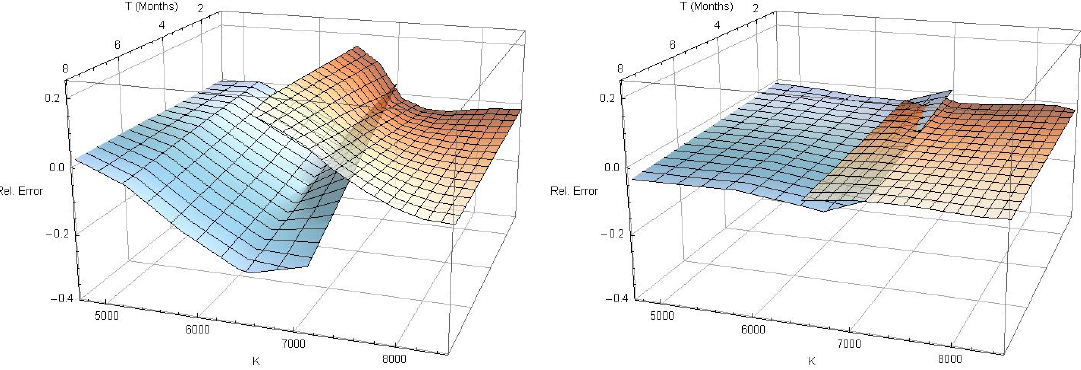
Figure 5. Valuation of European vanilla capped calls (blue) and puts (red) with the Black–Scholes model ( left ) and (2,2)-model of conditional pricing density ( right